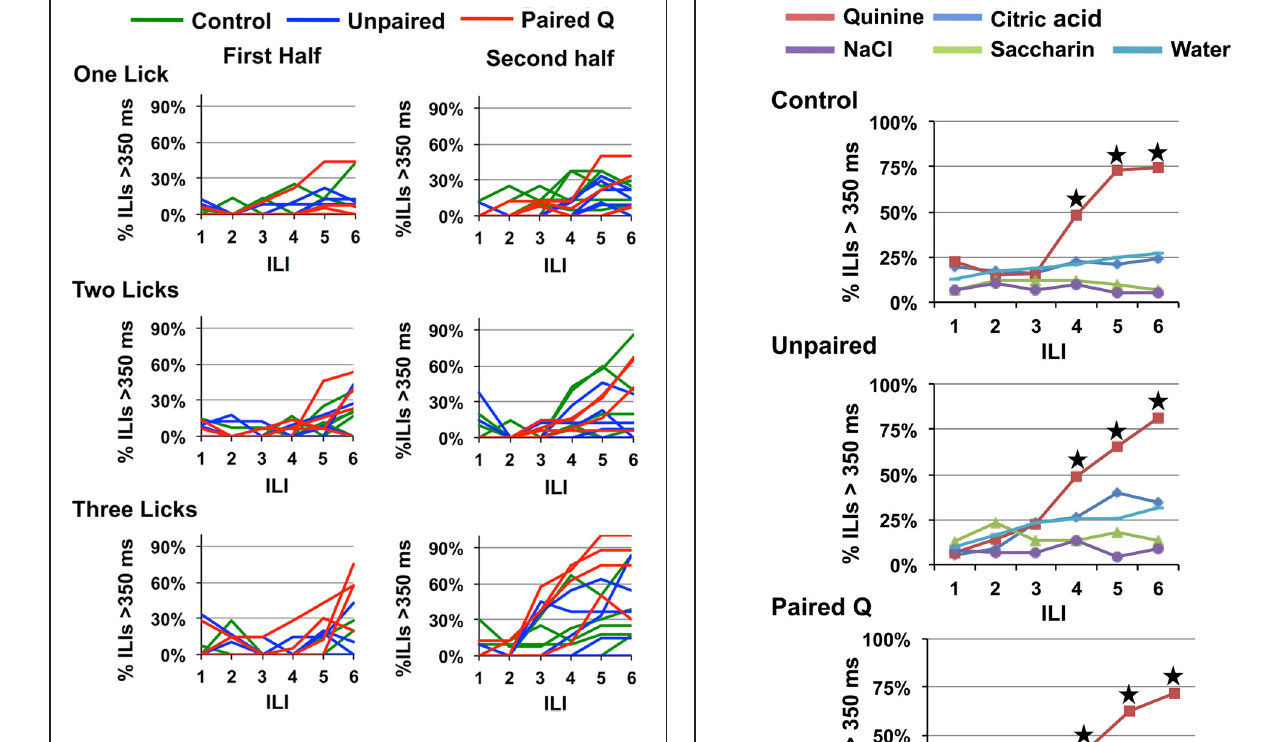
FIGURE 4 | Effects of motivation on speed of identification. Percentage of ILI’s above 350ms for quinine in individual rats is shown for the first and second half of the testing session. Division of the session is based on the total number of licks in any given session for each animal. Only one animal stopped licking after ILI-3 in the second half of the session.